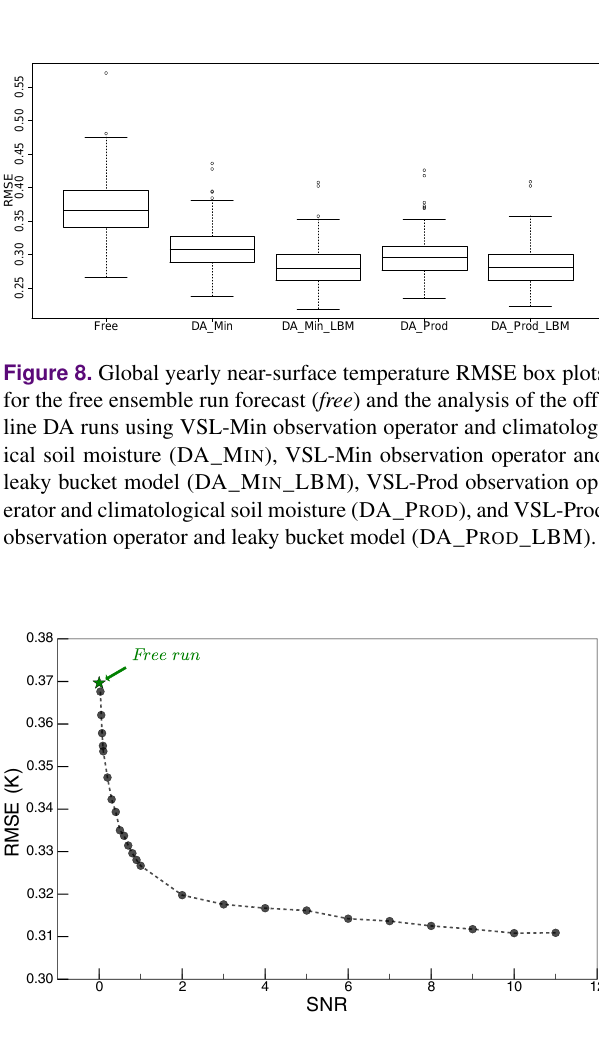
Figure 9. Averaged global yearly near-surface temperature RMSE for the analysis of the ensemble run with off-line DA, VSL-Min observation operator and different signal-to-noise ratios. The green star shows the corresponding value for the free